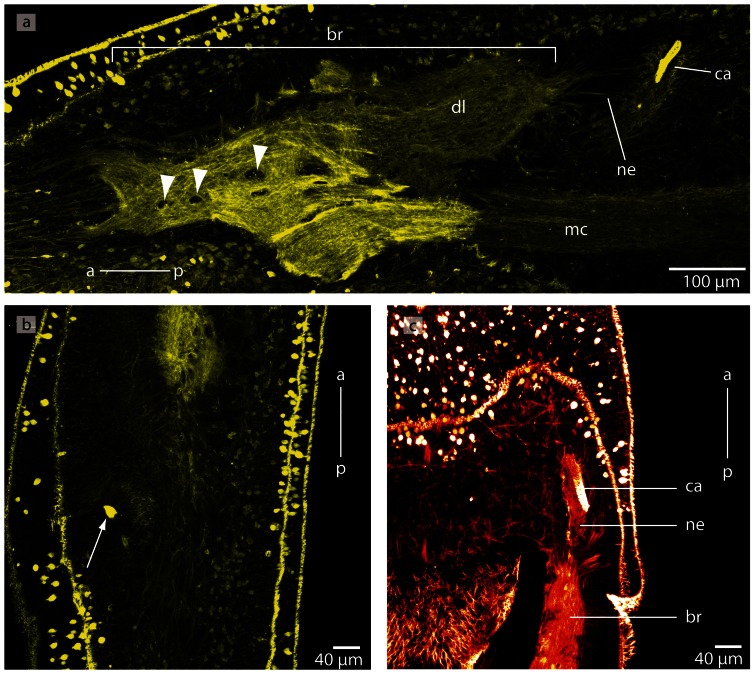

Carinina ochracea, confocal laserscanning (cLSM) micrographs of anti α-tubulin immunostained vibratome sections.
a: Sagital section. The neurites (ne) of the cells lining the canal of the cerebral organ are connected to the neuropil of the dorsal lobe (dl) of the brain (br). Note the unstained structures in the neuropil of the brain (arrowheads). b: sagital section. The canal terminates in a pit with a great number of cilia (arrow). c: horizontal section. The neurites (ne) of the sensory cells built a dense meshwork which is connected to the brain (br). ca canal of the cerebral organ, mc medullary cord.